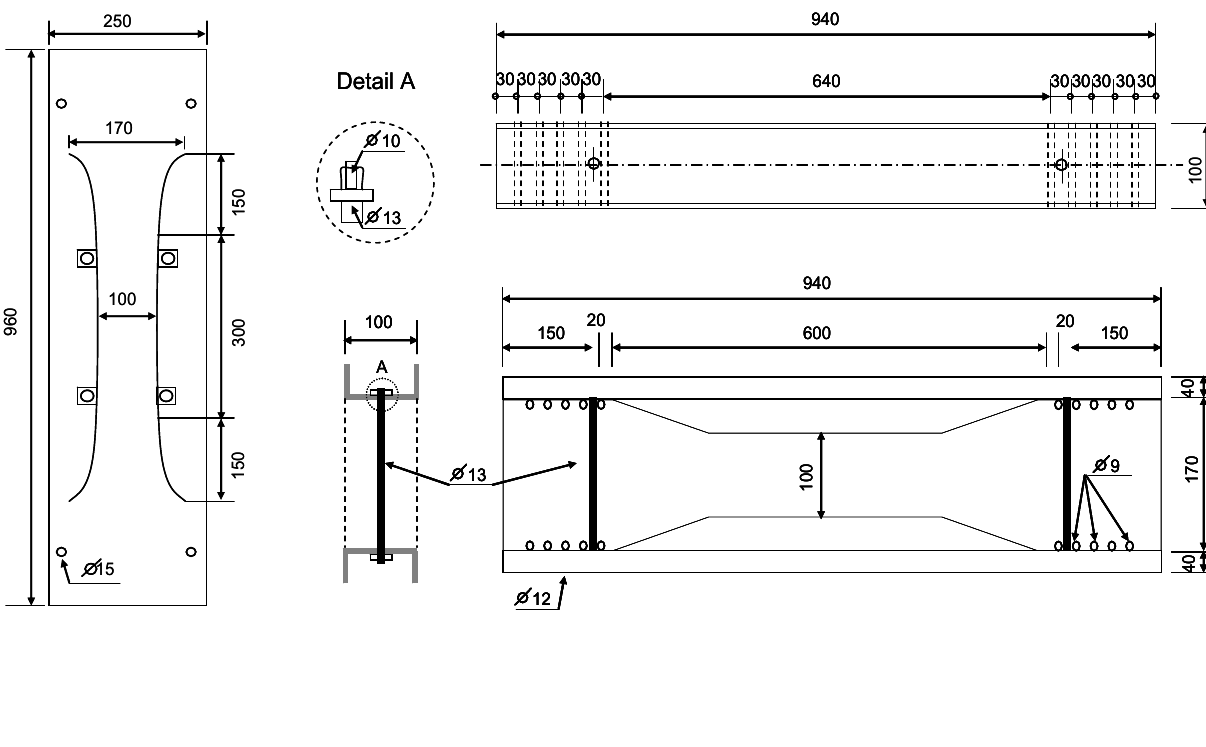
Figure 5. Restrained frame and concrete mold dimensions and details (units: